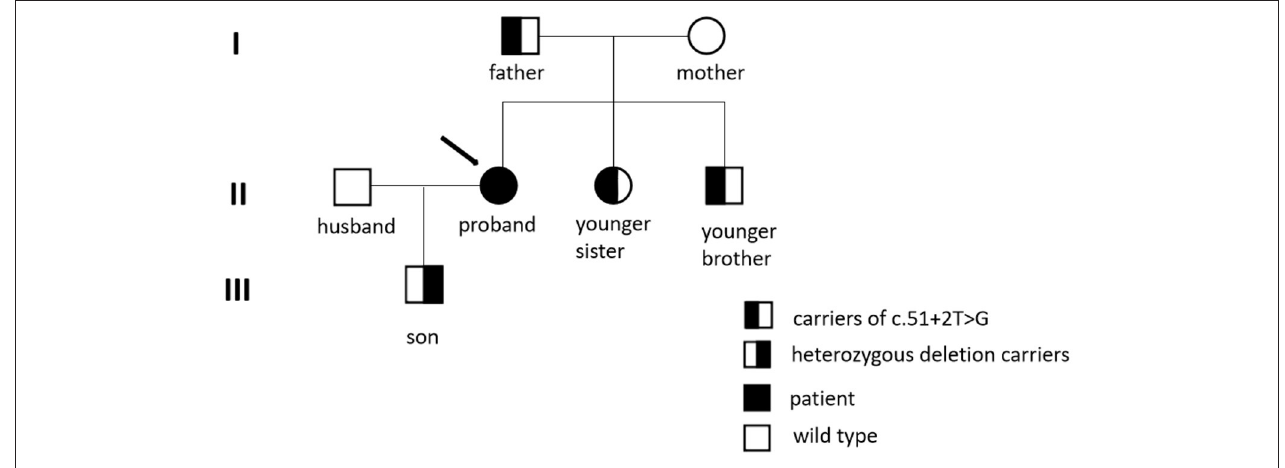
FIGURE 3 | Family pedigree of the mutation in c.51 + 2T > G and heterozygous